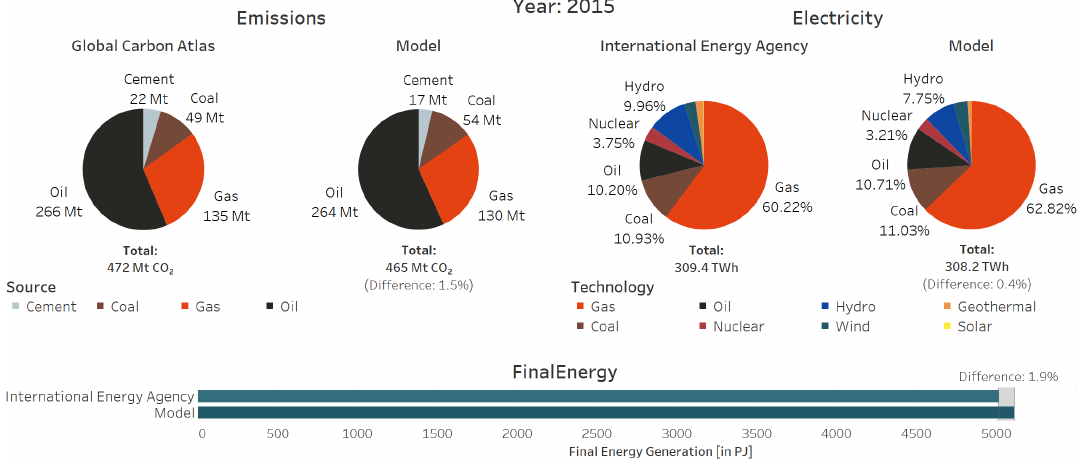
Figure A2. Comparison of model results with actual historical data for the year 2015. Data for emissions from Boden et al. [61], UNFCCC [62] and BP [63]; data for electricity from International Energy Agency [64]; and final energy from International Energy Agency